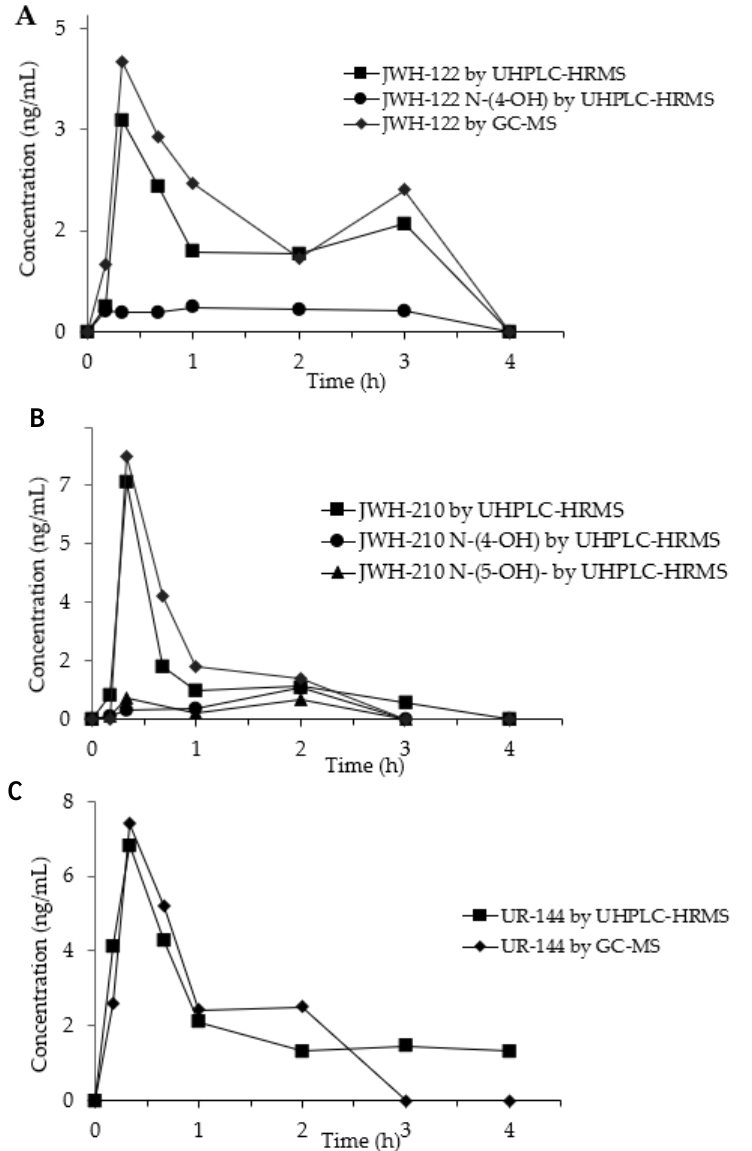
Figure 3. Concentration time-profiles of JWH-122 ( A ), JWH-210 ( B ), UR-144 ( C ) and their metabolites in OF of SCs consumers by GC-MS and UHPLC-HRMS.